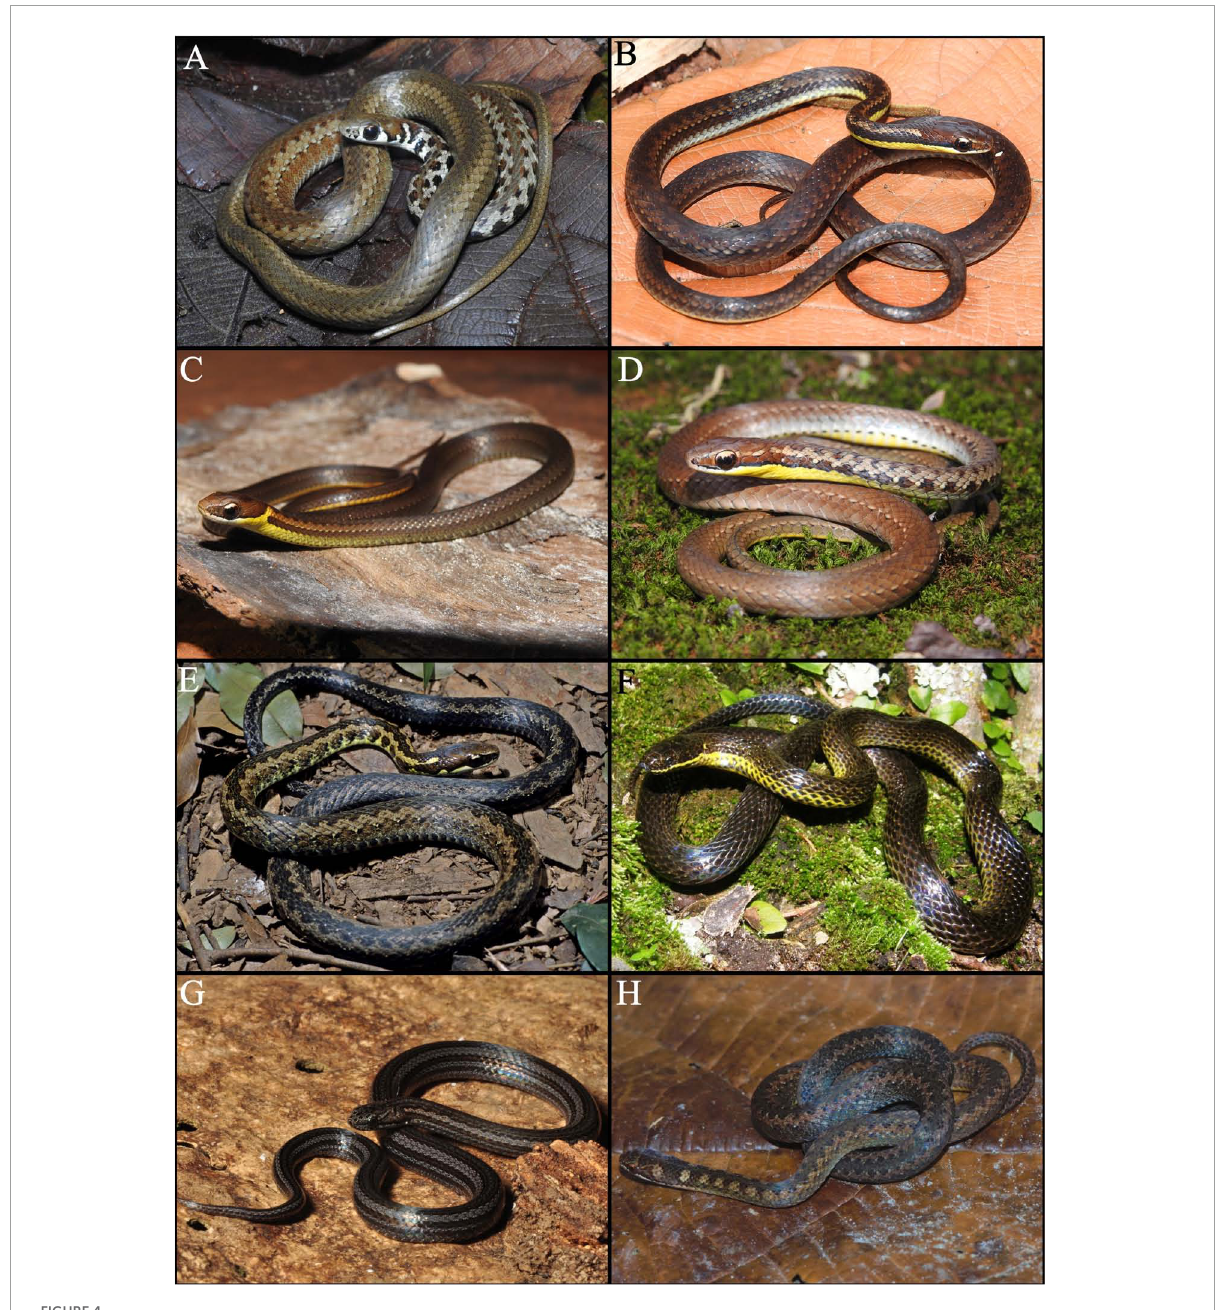
FIGURE4 General morphological aspects of some species representing the diversity of the genera Echinanthera , Sordellina and Taeniophallus . (A) Echinanthera cephalomaculata ; (B) Echinanthera cephalostriata ; (C) Echinanthera cyanopleura ; (D) Echinanthera melanostigma ; (E) Echinanthera undulata ; (F) Sordellina punctata ; (G) Taeniophallus brevirostris ; and (H) Taeniophallus nicagus .